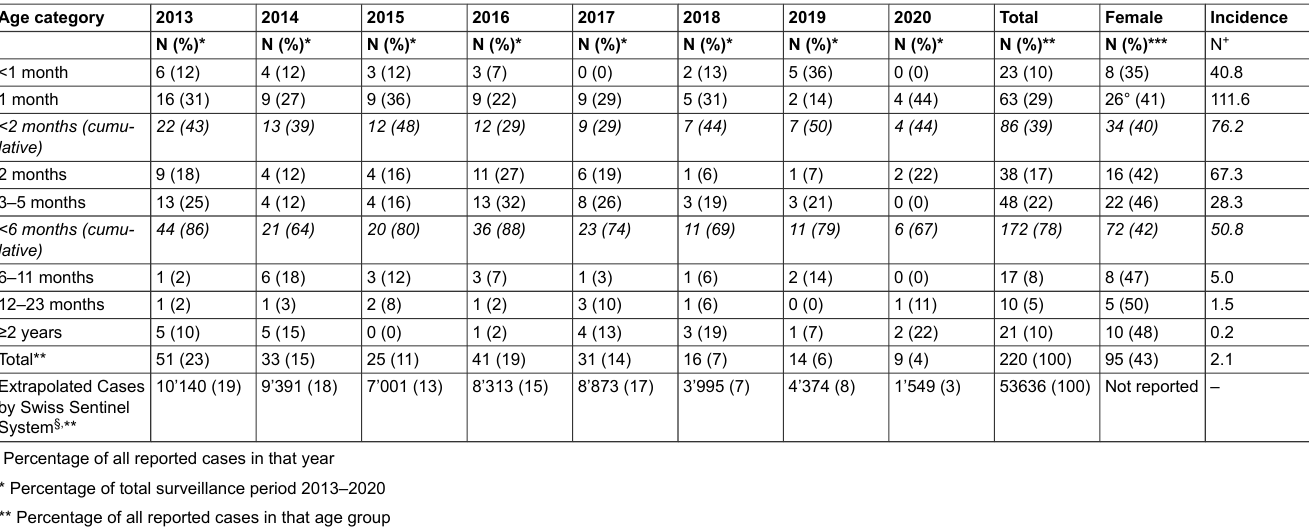
Table S2: Case counts by age categories, sex, and surveillance years.